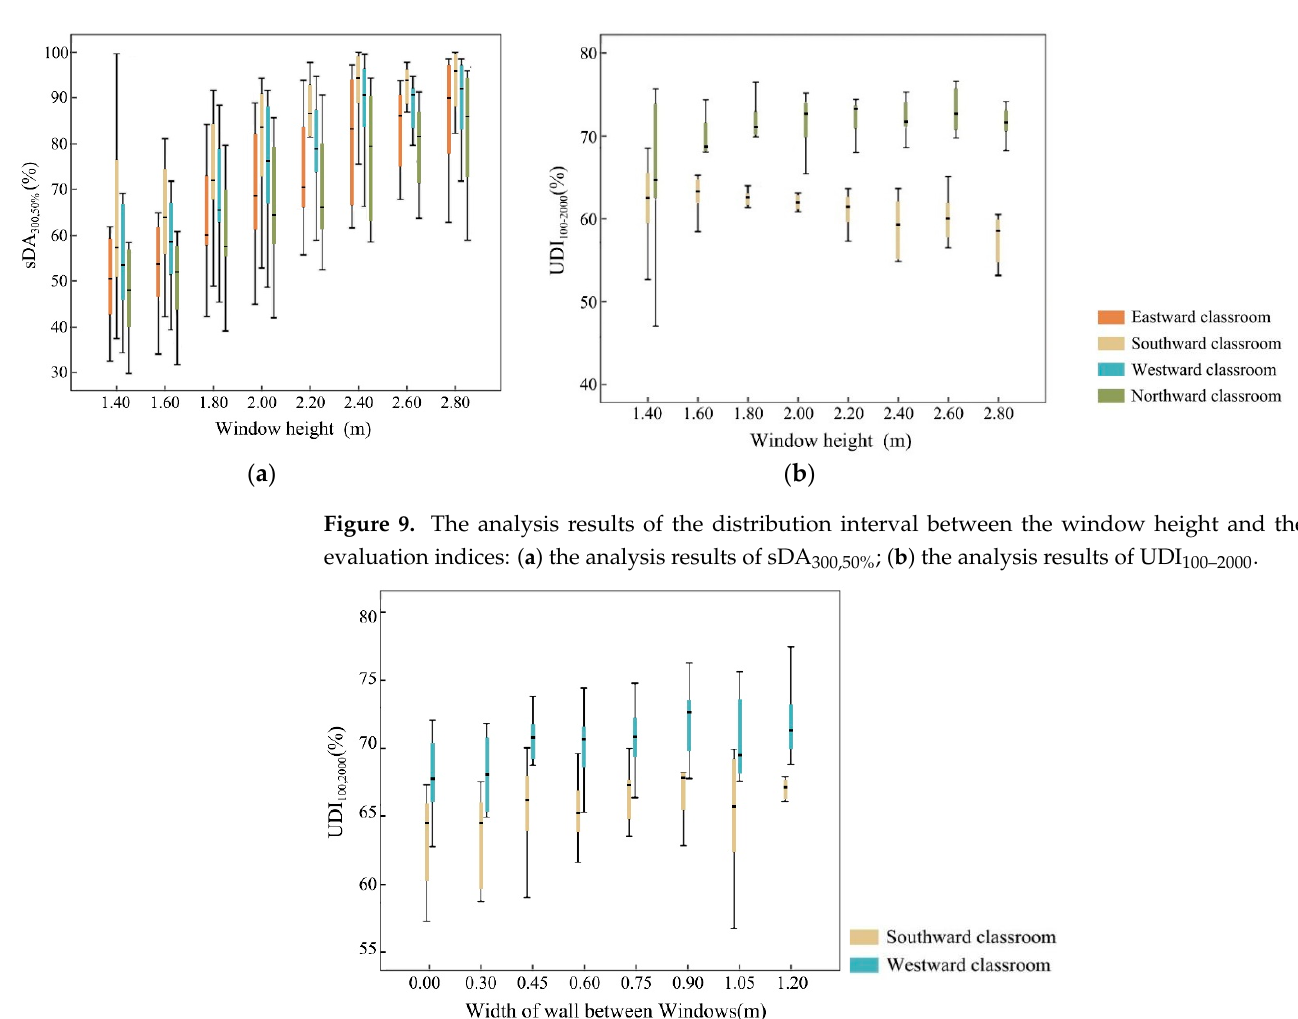
Figure 11. The analysis results of the distribution interval between the windowsill height and the evaluation index. In terms of the number of windows, only N w in north-facing classrooms had a signif- icant impact on sDA 300, 50% (Figure 12). When N w was 4, the median value of sDA 300, 50% was about 15% higher than other Nw. When N w was 5–9, with the increase in N w , the median value of sDA 300,50% changed a little, while the maximum and minimum values showed a clear downward trend.